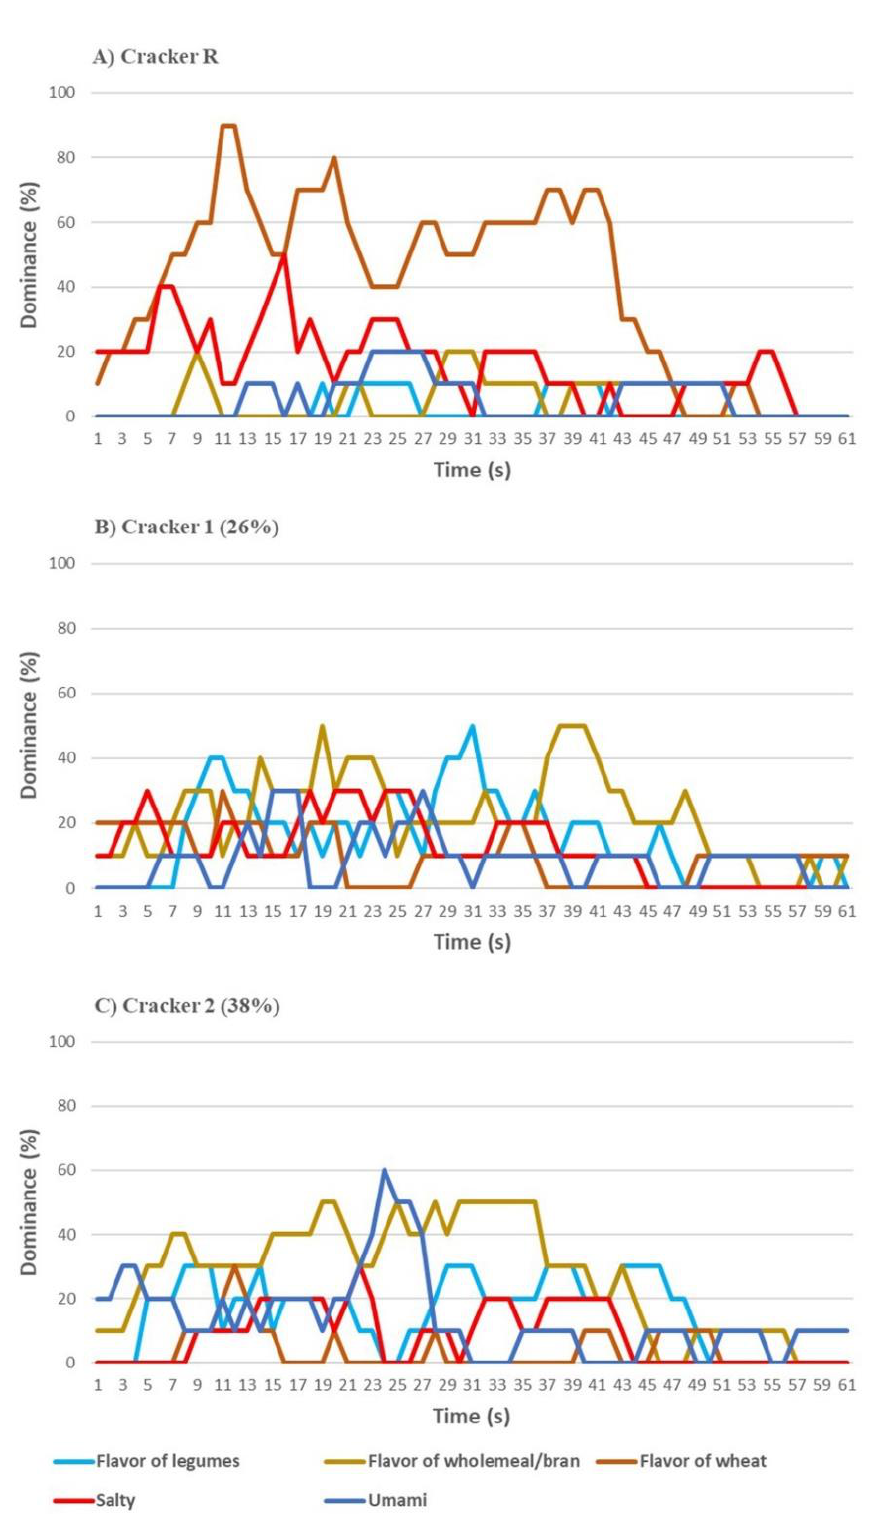
Figure 5. Temporal dominance of sensations (TDS) flavor of ( A ) Crackers R (reference, without common bean flour), ( B ) Crackers 1 (with 26% common bean flour) and ( C ) Crackers 2 (with 38% common bean flour).